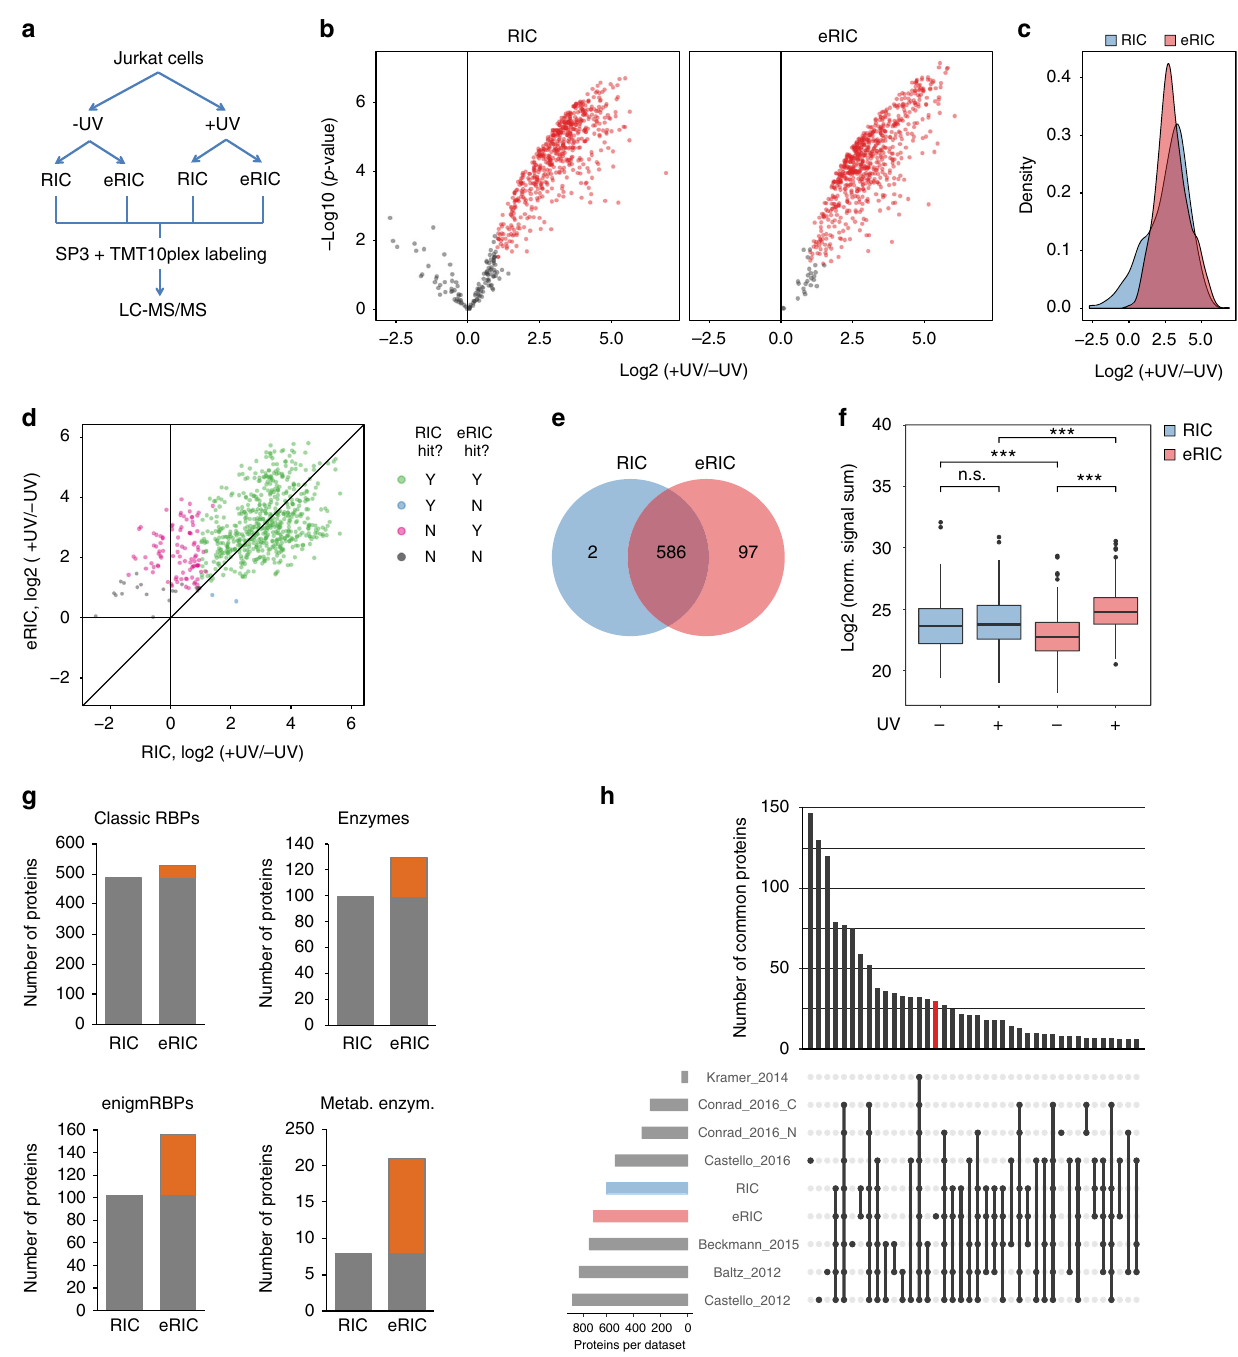
Fig. 3 Superior performance of eRIC in RBP detection. a Scheme of the work fl ow of the direct comparative analysis of eRIC and RIC. Proliferating Jurkat cells were irradiated or not, lysed, and lysates equally split for eRIC or RIC analyses. Concentrated eluates were subjected to SP3, TMT-labeled, and analyzed by MS. b Volcano plots displaying the log2-fold change (FC) in irradiated ( + UV) over non-irradiated ( − UV) samples ( x axis) and the p values ( y axis) of the proteins identi fi ed by eRIC (right) and RIC (left). Proteins with FDR<0.05 (moderated t test) and FC ≥ 2 were considered signi fi cantly enriched and are depicted in red. c Density of log2-FC between irradiated and non-irradiated samples of proteins identi fi ed by eRIC (red) and RIC (blue). Note the lack of enrichment over background of many proteins in RIC but not eRIC samples (leading left area of the blue curve). d Scatter plot comparing the averaged log2-FC in irradiated over non-irradiated samples of proteins detected by eRIC ( y axis) and RIC ( x axis). Hits recovered by both eRIC and RIC are displayed in green, hits unique to eRIC or RIC in magenta and blue, respectively, and proteins identi fi ed as background by both methods are shown in black. e Venn diagram comparing the number of hits identi fi ed by eRIC and RIC. f Normalized signal sum in irradiated and non-irradiated samples of the 97 hits exclusively identi fi ed by eRIC. *** p <0.001 (Wilcoxon signed-rank test); n.s.:not signi fi cant. Center lines represent medians, box borders represent the interquartile range (IQR), and whiskers extend to ±1.5× the IQR; outliers are shown as black dots. g Number of known RBPs, enzymes, enigmRBPs 4 , and metabolic enzymes identi fi ed by eRIC and RIC. Orange boxes represent the hits exclusive to eRIC. h UpSet plot showing the number of common proteins (i.e., intersections) between the eRIC and RIC experiments presented here or in previously published RBP datasets. Conrad_2016_C and _N refers to cytoplasmic and nuclear datasets 3 , respectively. Data correspond to two